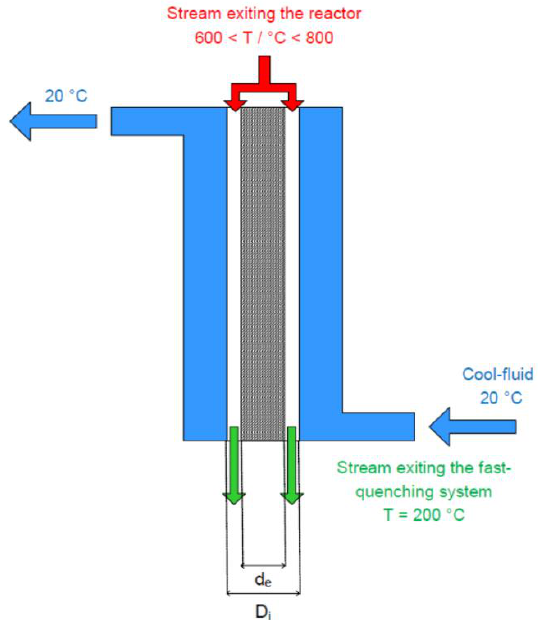
Figure 3. Schematic overview of the fast-quenching system (longitudinal section).